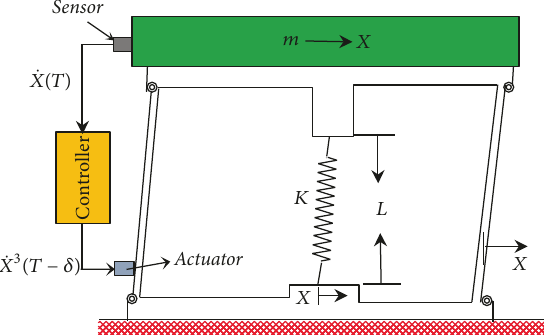
Figure 1: The mechanical model with negative stiffness device (NSD) under feedback control.